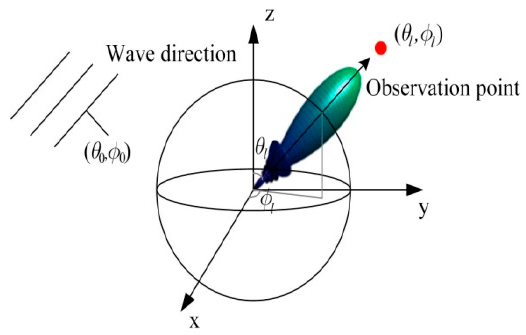
Figure 1. Sound source localization model for the spherical array.